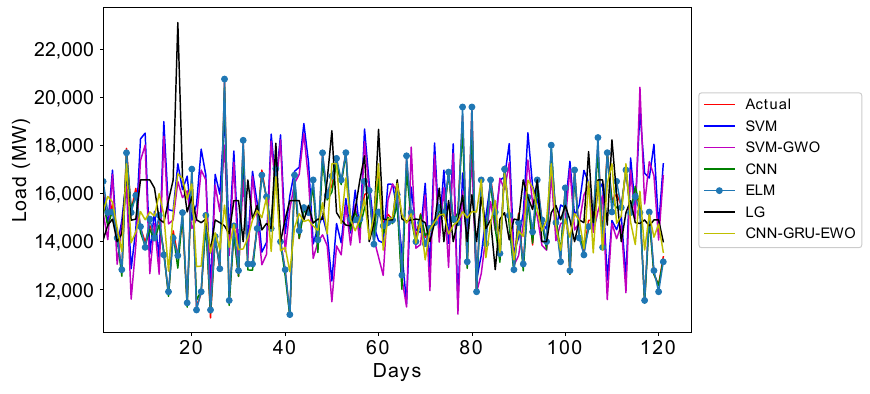
Figure 15. Four-month